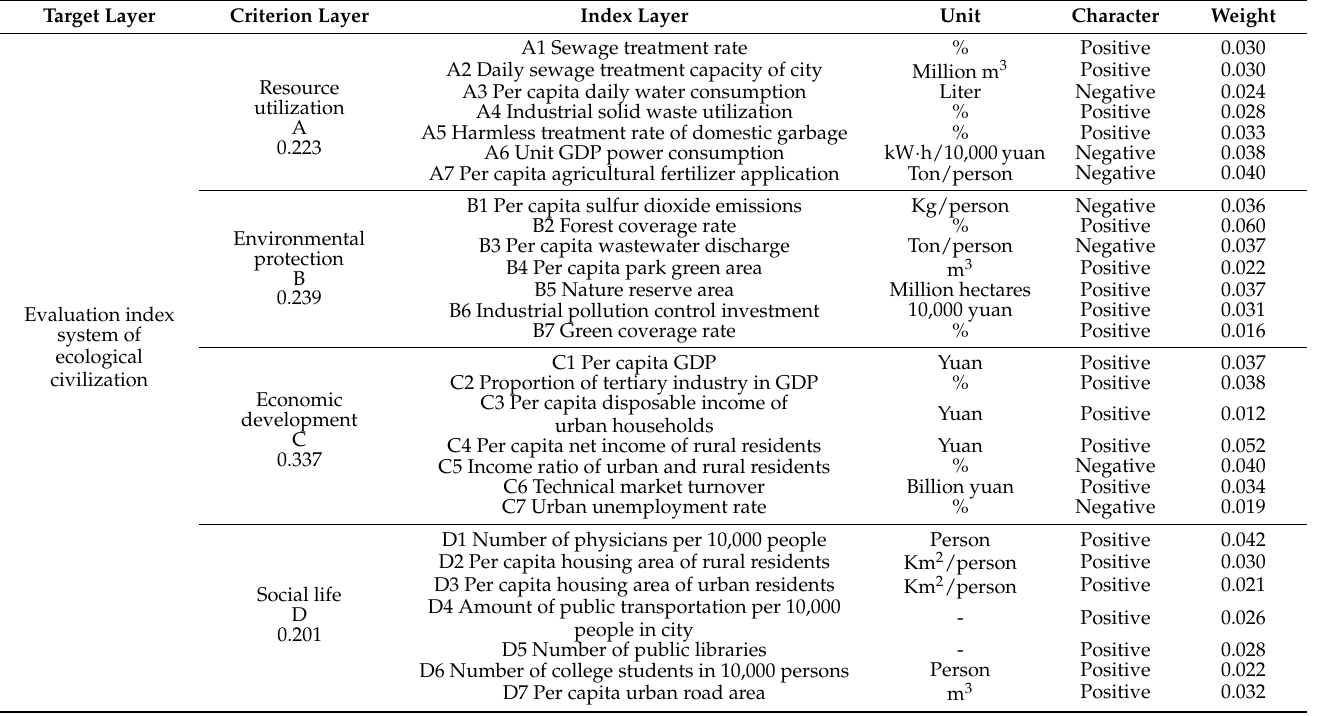
Table 1. Ecological civilization effectiveness evaluation